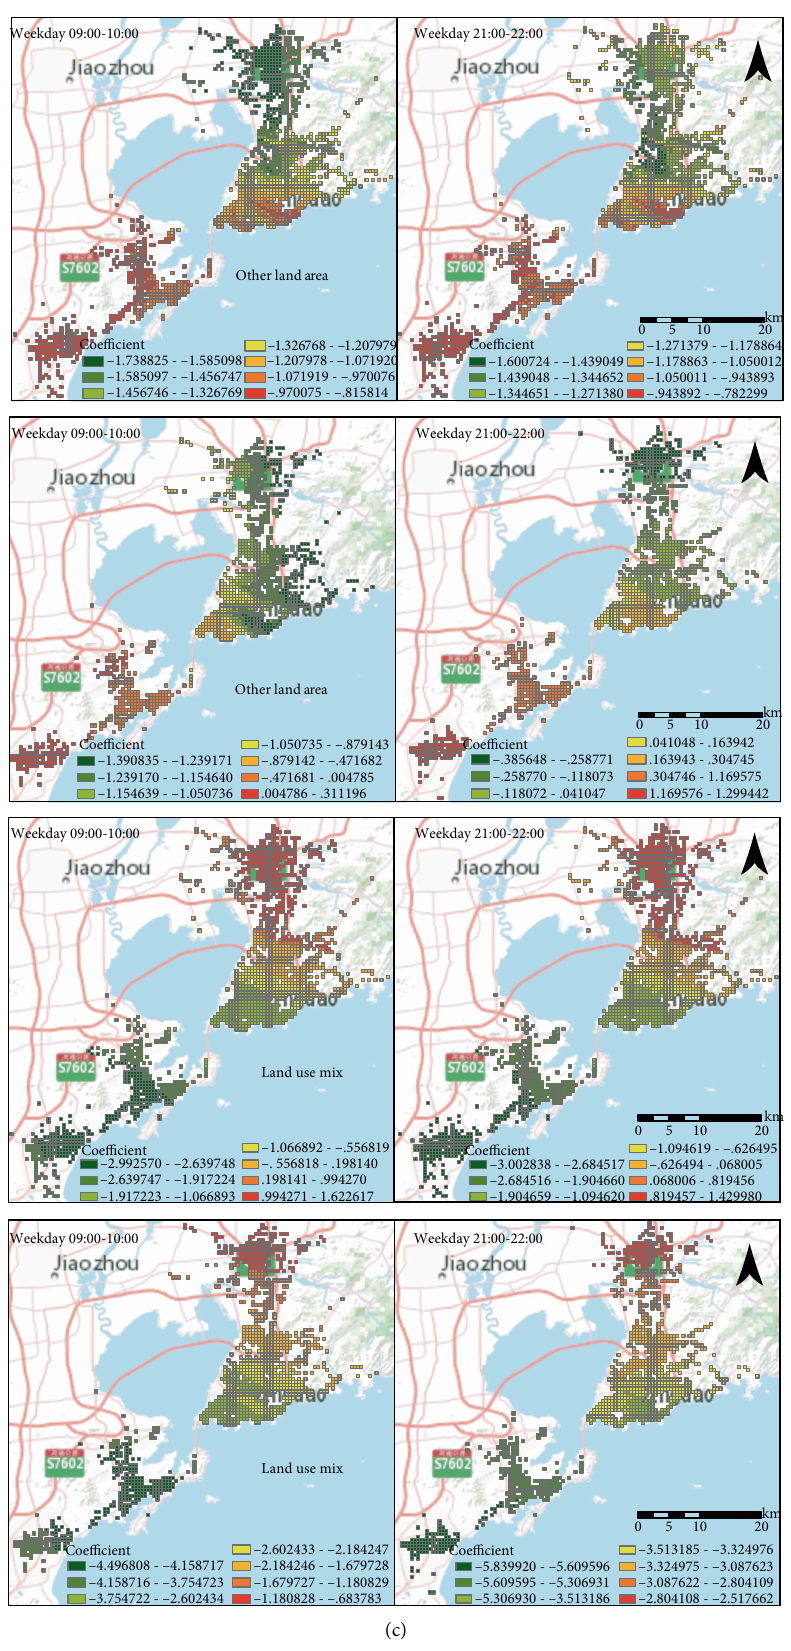
Figure 10: Spatial distribution for the coefficients of land use factors for weekday and